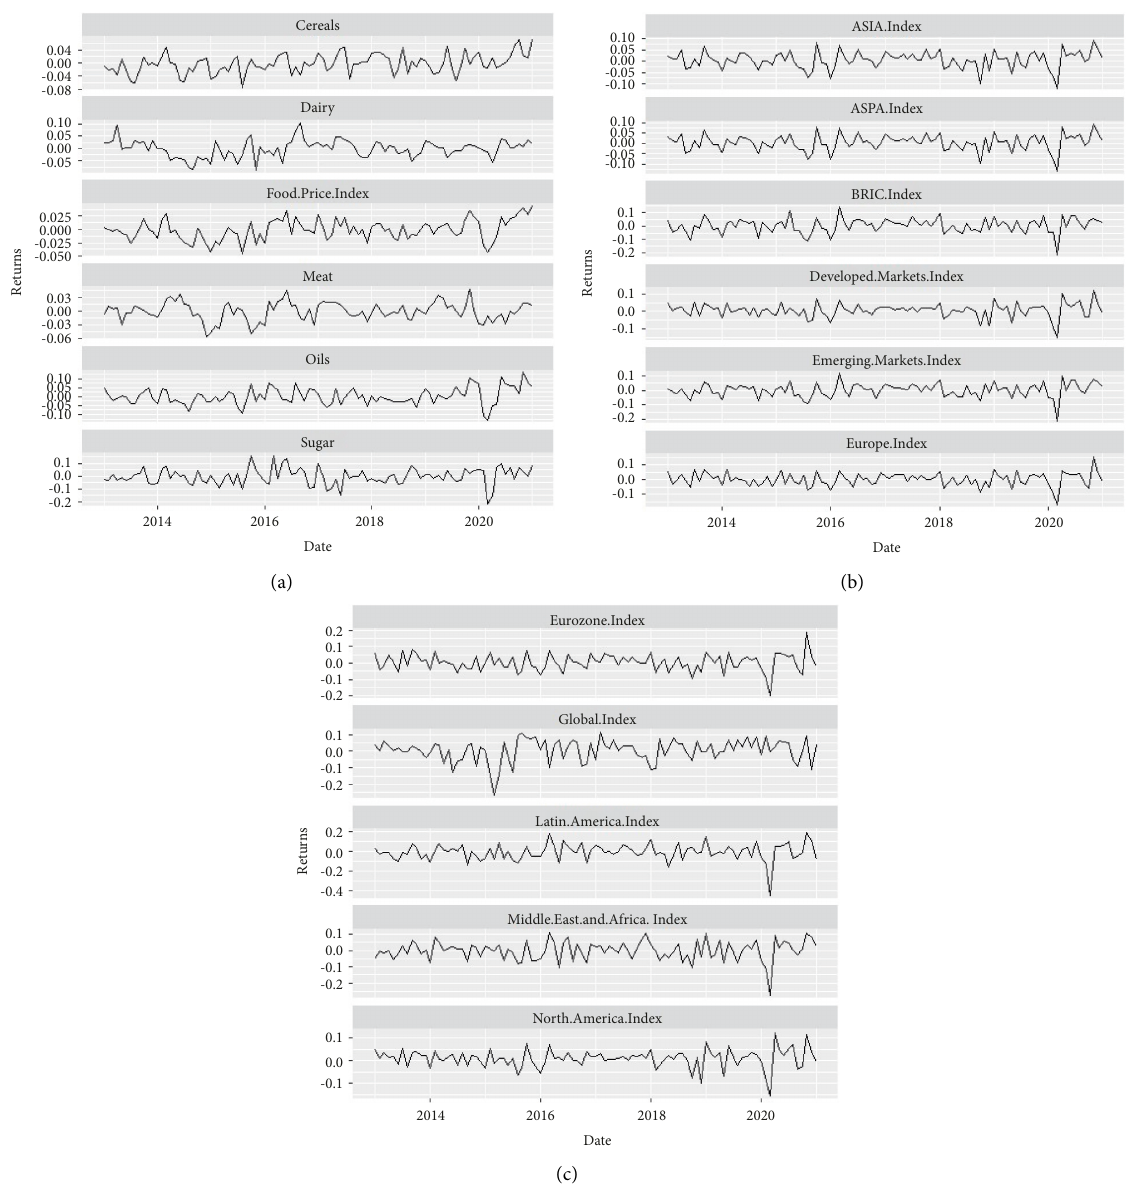
Figure 2: Time series plots of food commodity